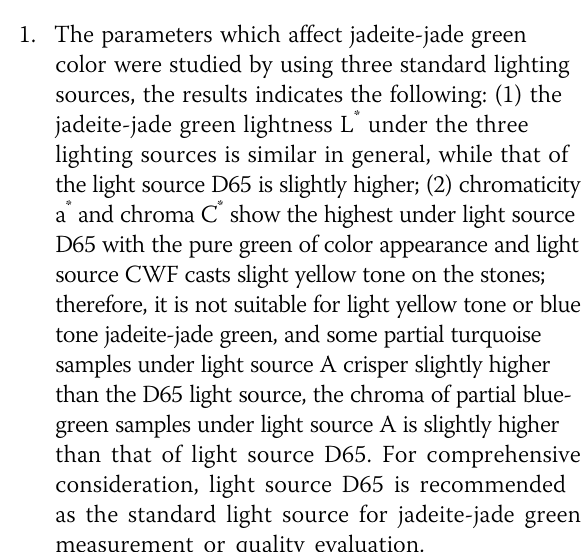
Table 6 Fisher discrimination count and accuracy of GemDialogue color blocks of imitated Jadeite-Jade